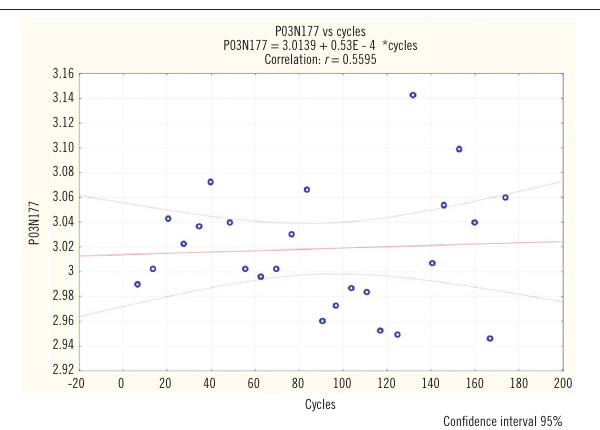
figurE 2 − Linear regression of the IQC anti-treponemal P03N177 batch based on 174 cycles of F/T IQC: internal quality control; F/T: freeze/thaw.